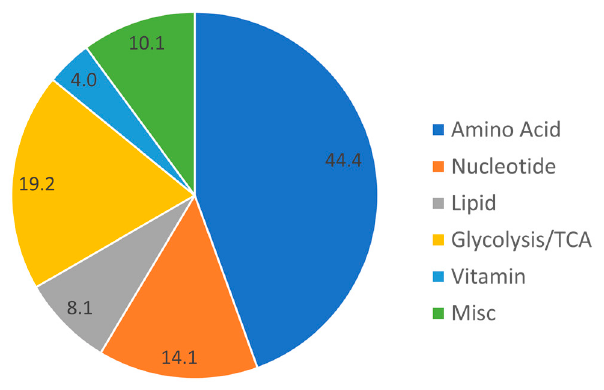
Figure 1. Pie chart of the metabolite categories present in the CSF.